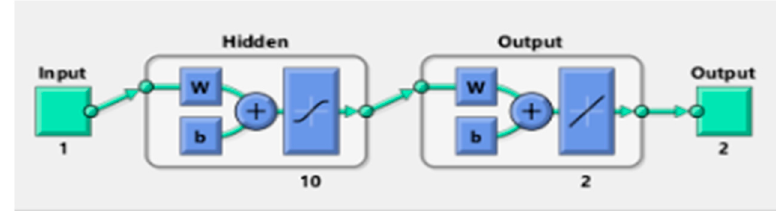
Figure 2. Neural Network diagram for TD-PNFM.